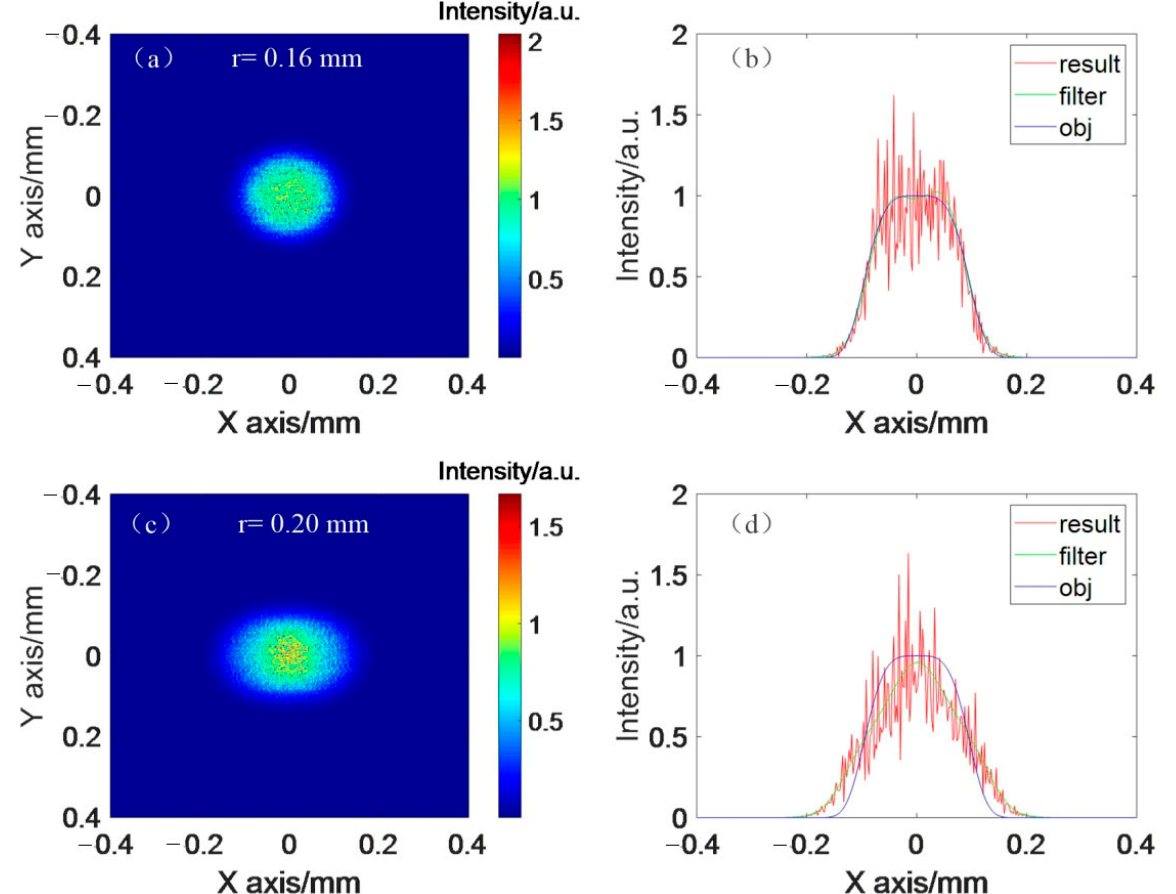
Figure 3. Simulations results of the far-field focal spot with different modulation indexes after SSD and CPP: ( a , b ) Focal spot and its light intensity at transverse plane with modulation index corresponding to spectral width = 0.1 nm. ( c , d ) Focal spot and its light intensity at transverse plane with modulation index corresponding to spectral width = 0.5 nm.